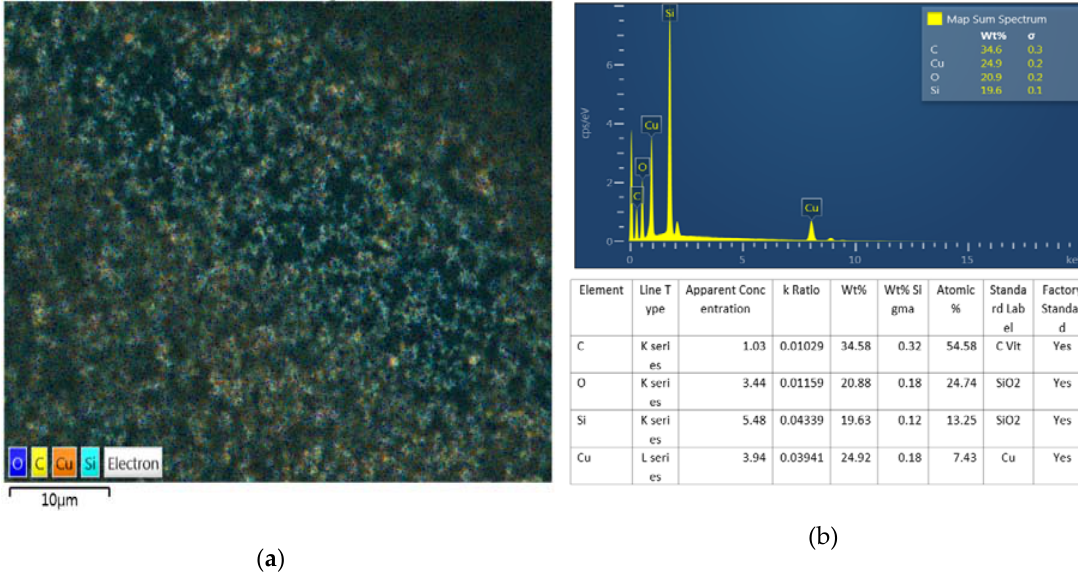
Figure 5. SEM images of ( a ) SEI (Secondary Electron Image) of Cu particles (A), ( b ) EDS (Energy Dispersive Spectrometer) of Cu particles (A), ( c ) SEI of Cu particles (B); ( d ) EDS of Cu particles (B).